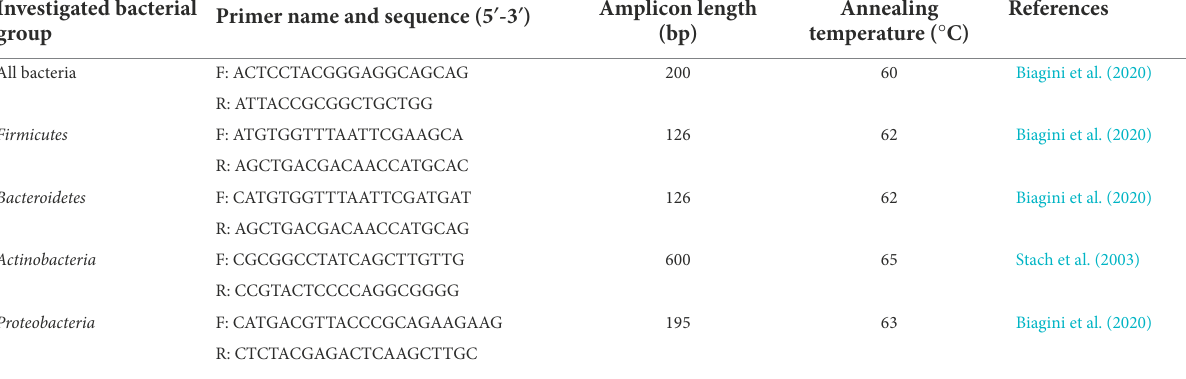
TABLE 1 Primer pairs used in this study for the quantification of total bacterial load and microbial phyla. Investigated bacterial group